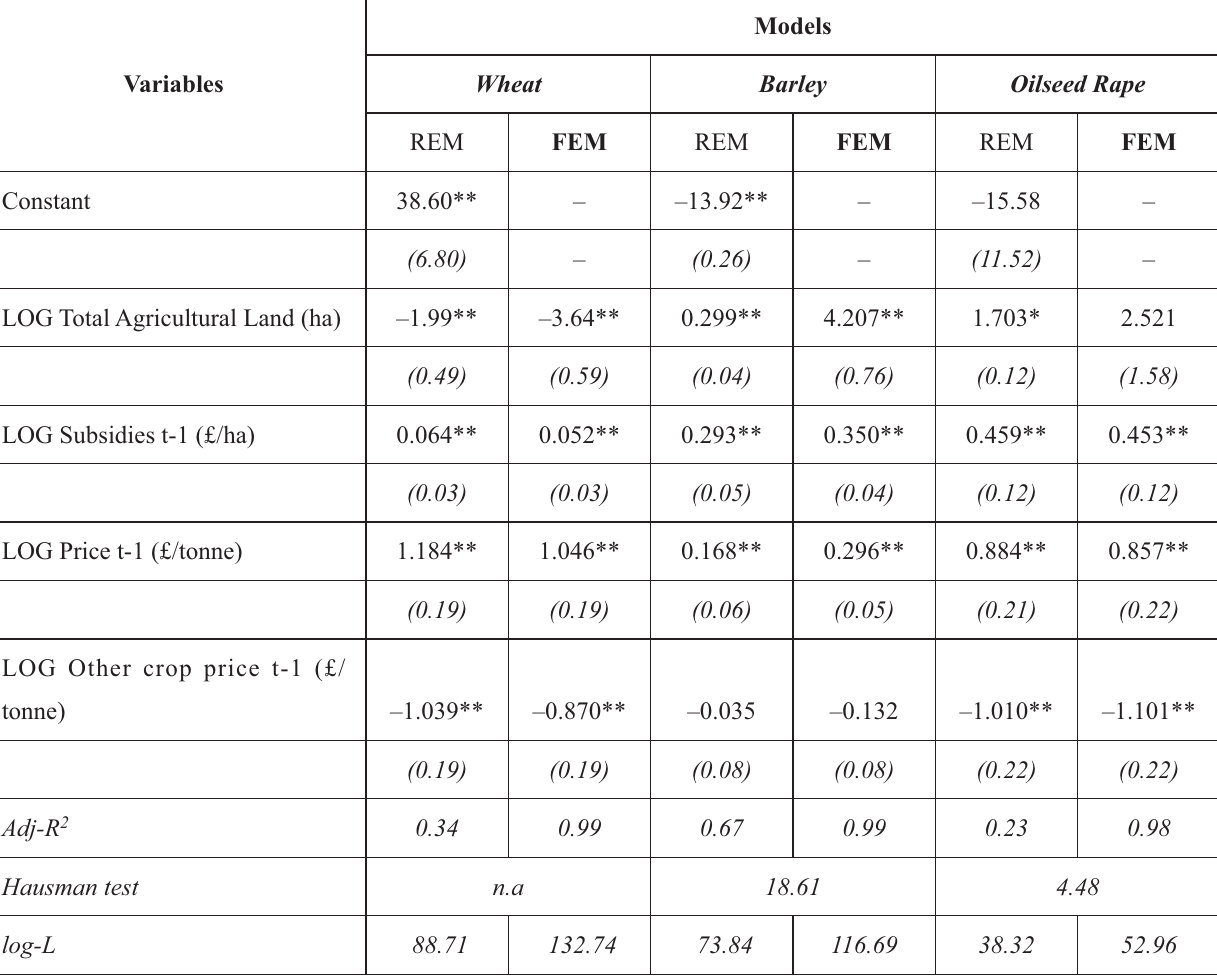
Table 1. Comparison of results of land allocation models excluding production cost (dependent